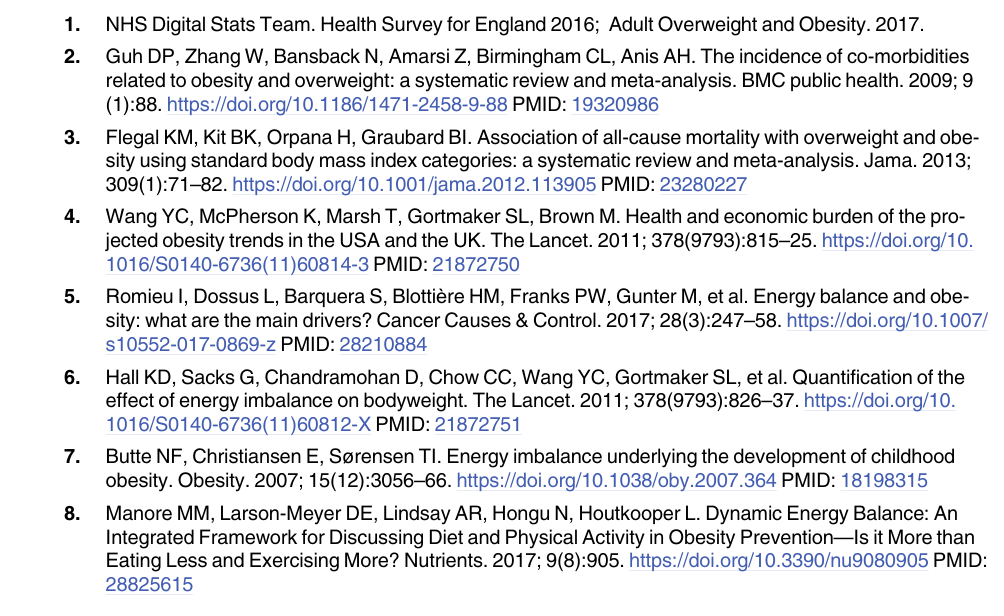
S3 Data. Data file containing supermarket data on products chosen after each swap offer for each